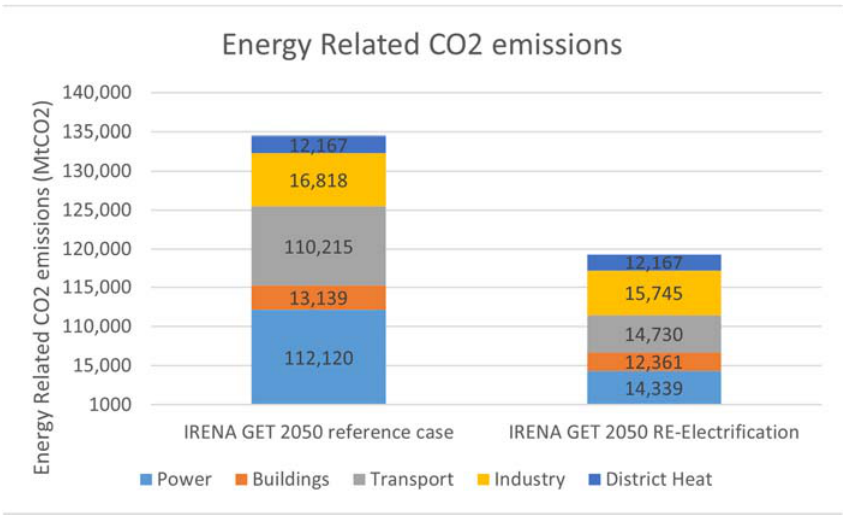
Figure 1. Projected energy ‐ related CO2 emissions, authors’ elaboration from [2,3].